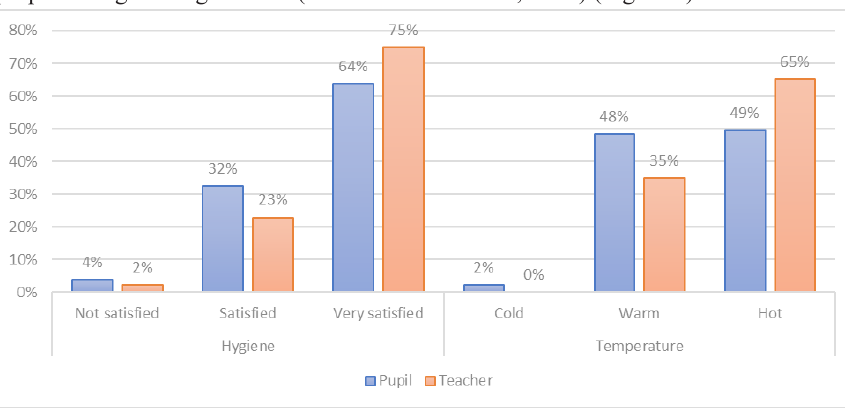
Fig. 5: Perception of Hygiene in the Serving Area and Temperature of Food Served Source: Field